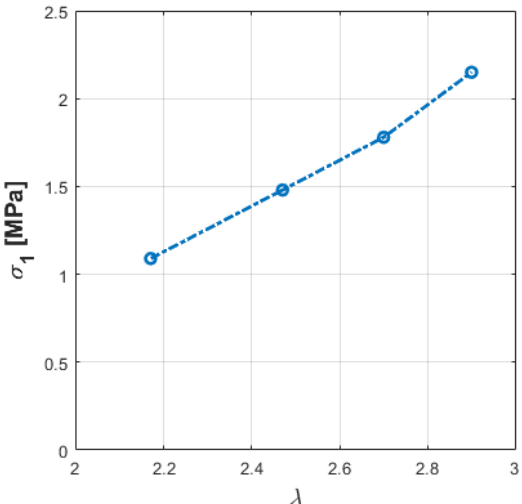
Figure 6. Relationship between the stress for a null load σ 1 and the actuator deformation λ .